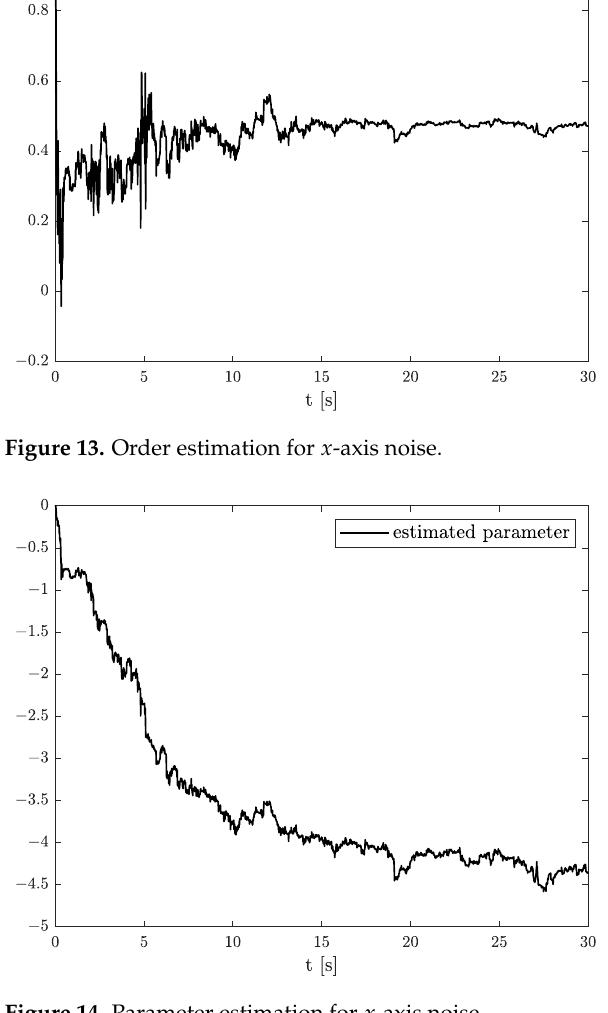
Figure 14. Parameter estimation for x -axis noise.